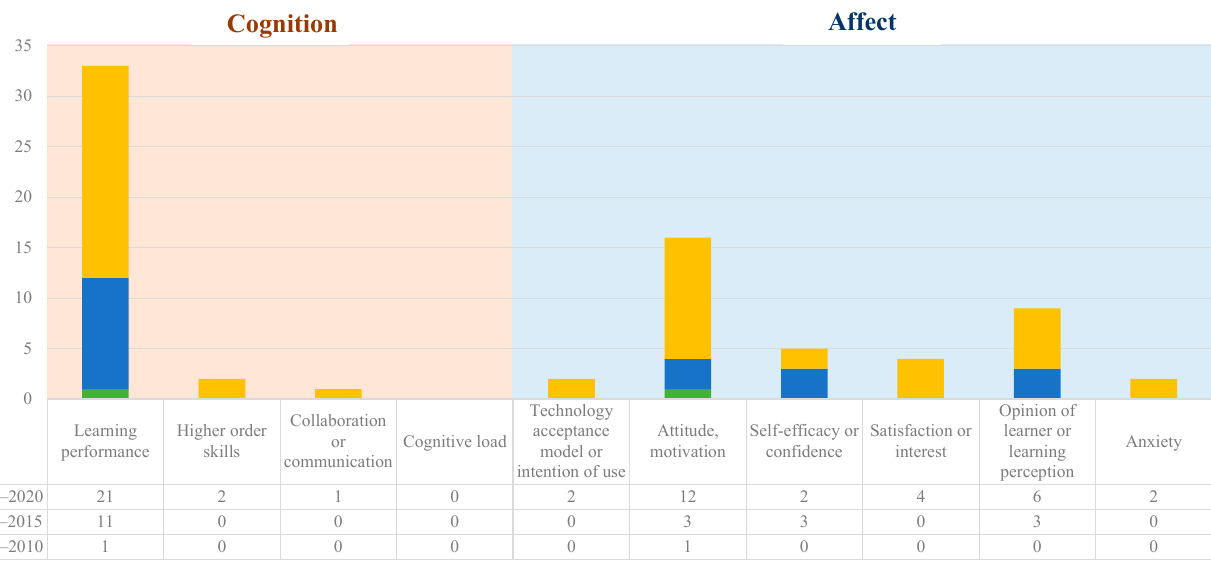
Figure 15. Research issues in the cognition and affect aspects.